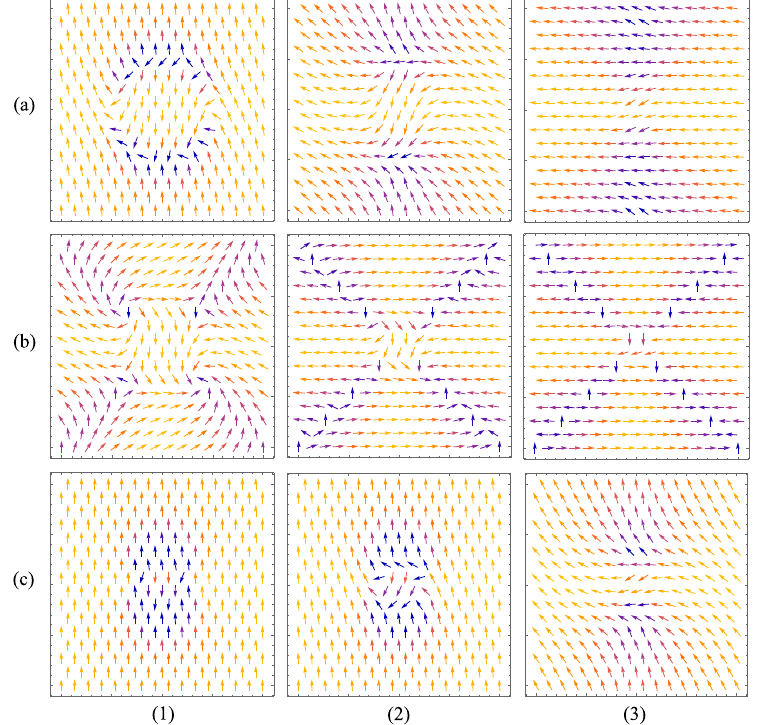
Figure 5. The vector field representing the expected value of ( σ x , σ z ) operator with respect to the state Ψ − ( k x , k y ) (4) on the ( k x , k y ) domain. The horizontal labels (1), (2), (3) represent values of parameter γ = 0.1, 1, 10, respectively, while the vertical ones are: ( a ) ( m , n ) = ( 1,1 ) , C = − 0.998, − 0.854, and − 0.651, respectively; ( b ) ( m , n ) = ( 1,2 ) , C = − 1/2, ( c ) ( m , n ) = ( 2,1 ) , C = − 1. The topologically trivial case for which the bands touch ( γ = 0, C = 0 ) would have all “spins” directed